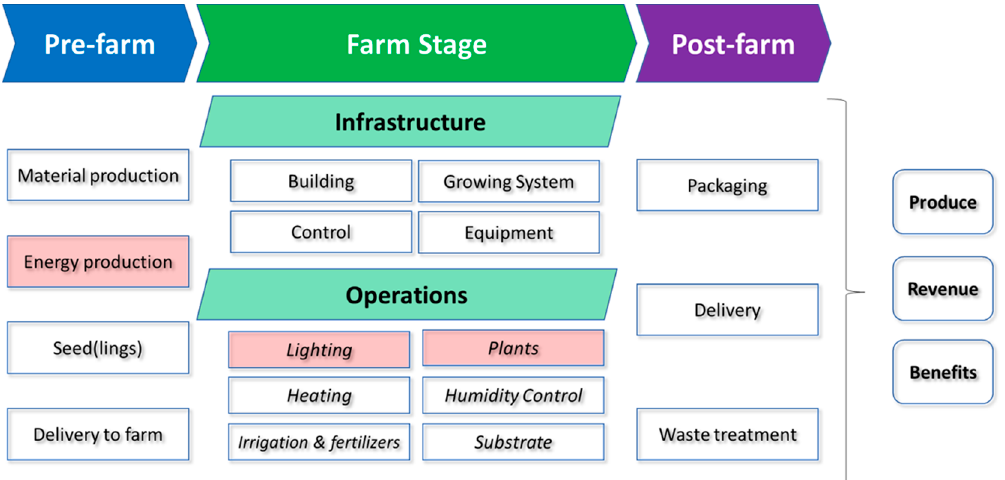
Figure 1. Vertical farming system activities organised in a life cycle assessment process diagram to highlight the carbon costs in controlled environment agriculture. Groups highlighted in red represent activities with high environmental impact that are addressed in this review.